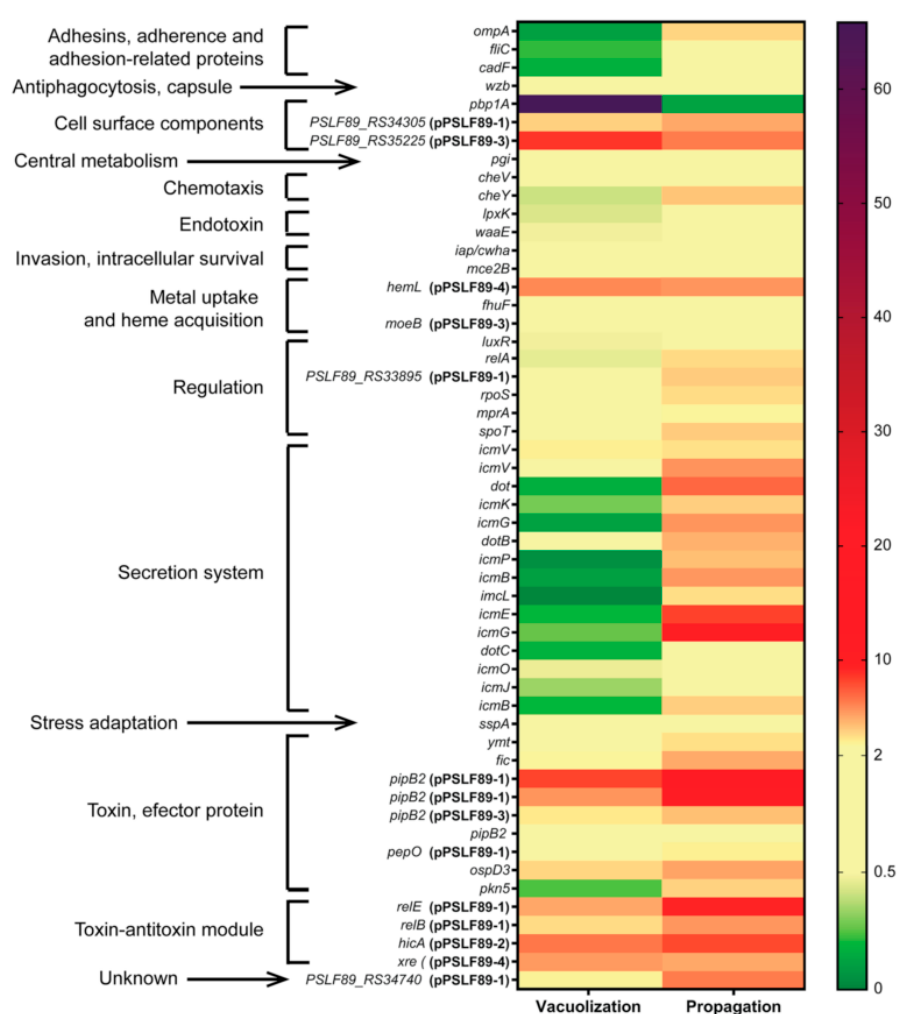
Figure 7. Heat map showing expression levels of P. salmonis virulence factors in SHK-1 infected cells. Expression levels of P. salmonis genes are expressed as ΔΔ Ct values normalized by exponential culture bacteria as control, and recF and rho genes as housekeeping genes. ΔΔ Ct values were used to create a heat map: values between 0.5 and 2 (yellow) correspond to expression levels similar to control bacteria, increased expression relative to control bacteria is shown in red and purple, and decreased expression in green. Virulence factors were classified in families as before (Figure 5).